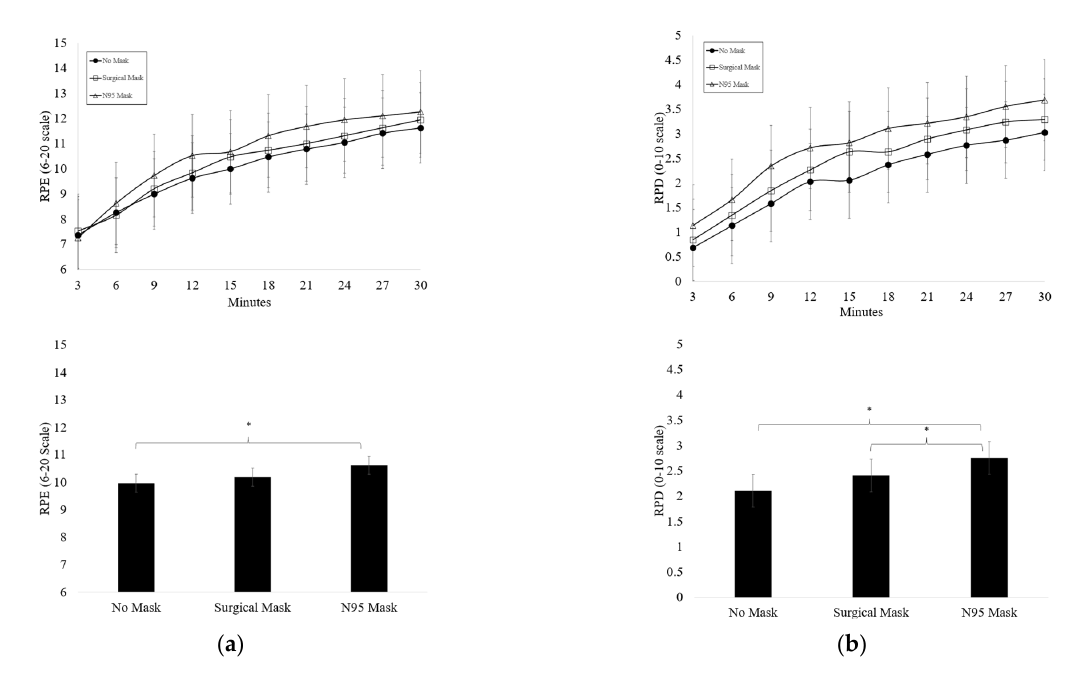
Figure 4. ( a ) Average rating of perceived exertion (RPE) (mean ± SD) during each testing condition ( n = 19) * Significant main effect for condition ( p < 0 .05); ( b ) average rating of perceived dyspnea (RPD) (mean ± SD) during each testing condition ( n = 19) * Significant main effect for condition ( p < 0 .05)